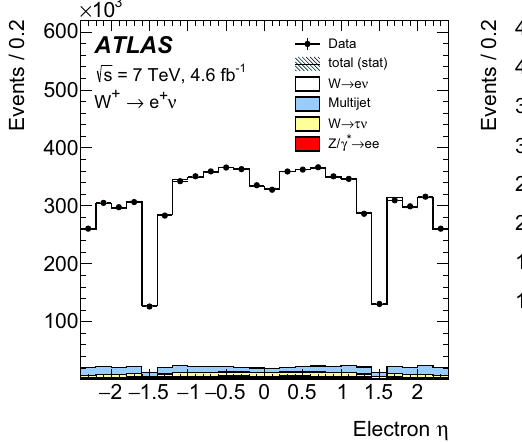
mated yield of multijet events. The sum of all expected background and signal contributions is shown as a solid line with a hashed band detail- ing the statistical uncertainty and labelled “total (stat)”. The legend lists only background sources with a visible